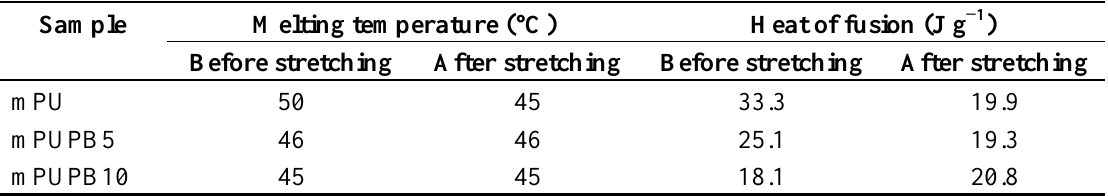
Table 6. Comparison of melting temperature and heat of fusion of crystalline soft segment before and after 100%